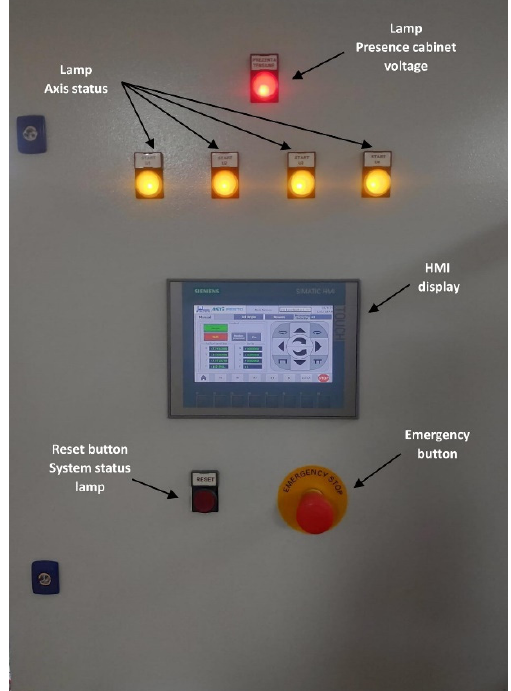
Figure 10. Command and control panel.